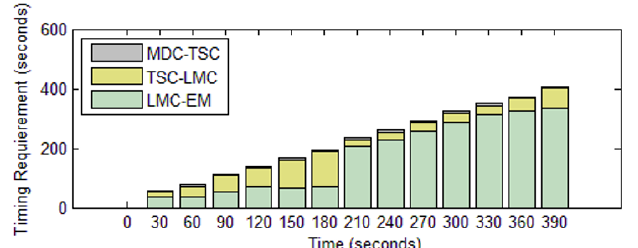
Figure 5. Timing analysis along the EM to MDC data path during the periodic acquisition of load profile data.